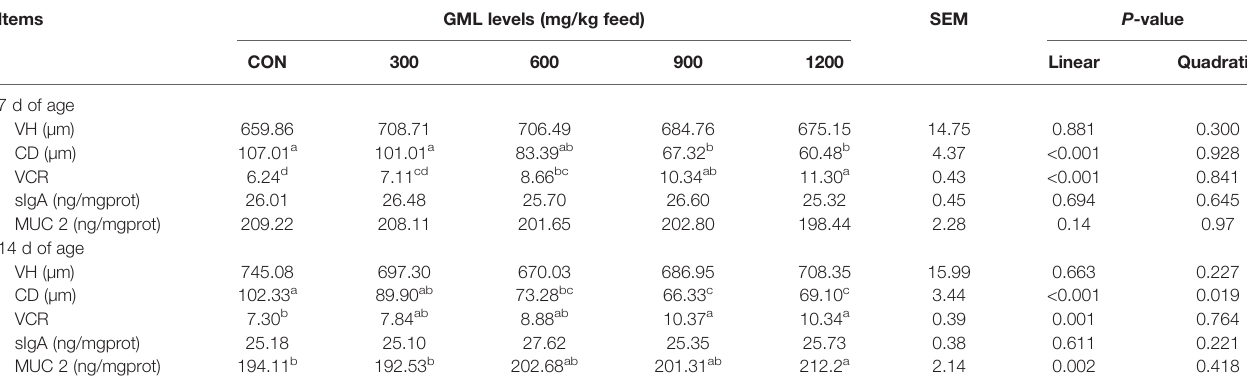
TABLE 5 | Effects of dietary treatment on the jejunal morphology, sIgA, and MUC 2 of 7- and 14-day-old broilers. Items GML levels (mg/kg feed) SEM P -value CON 300 600 1200 Linear Quadratic